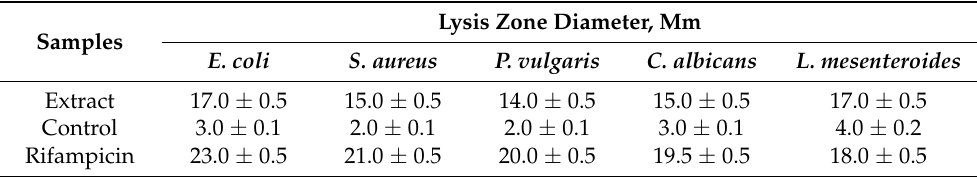
Table 4. The results of evaluating the antimicrobial activity of Dactylorhiza maculata extracts. Samples